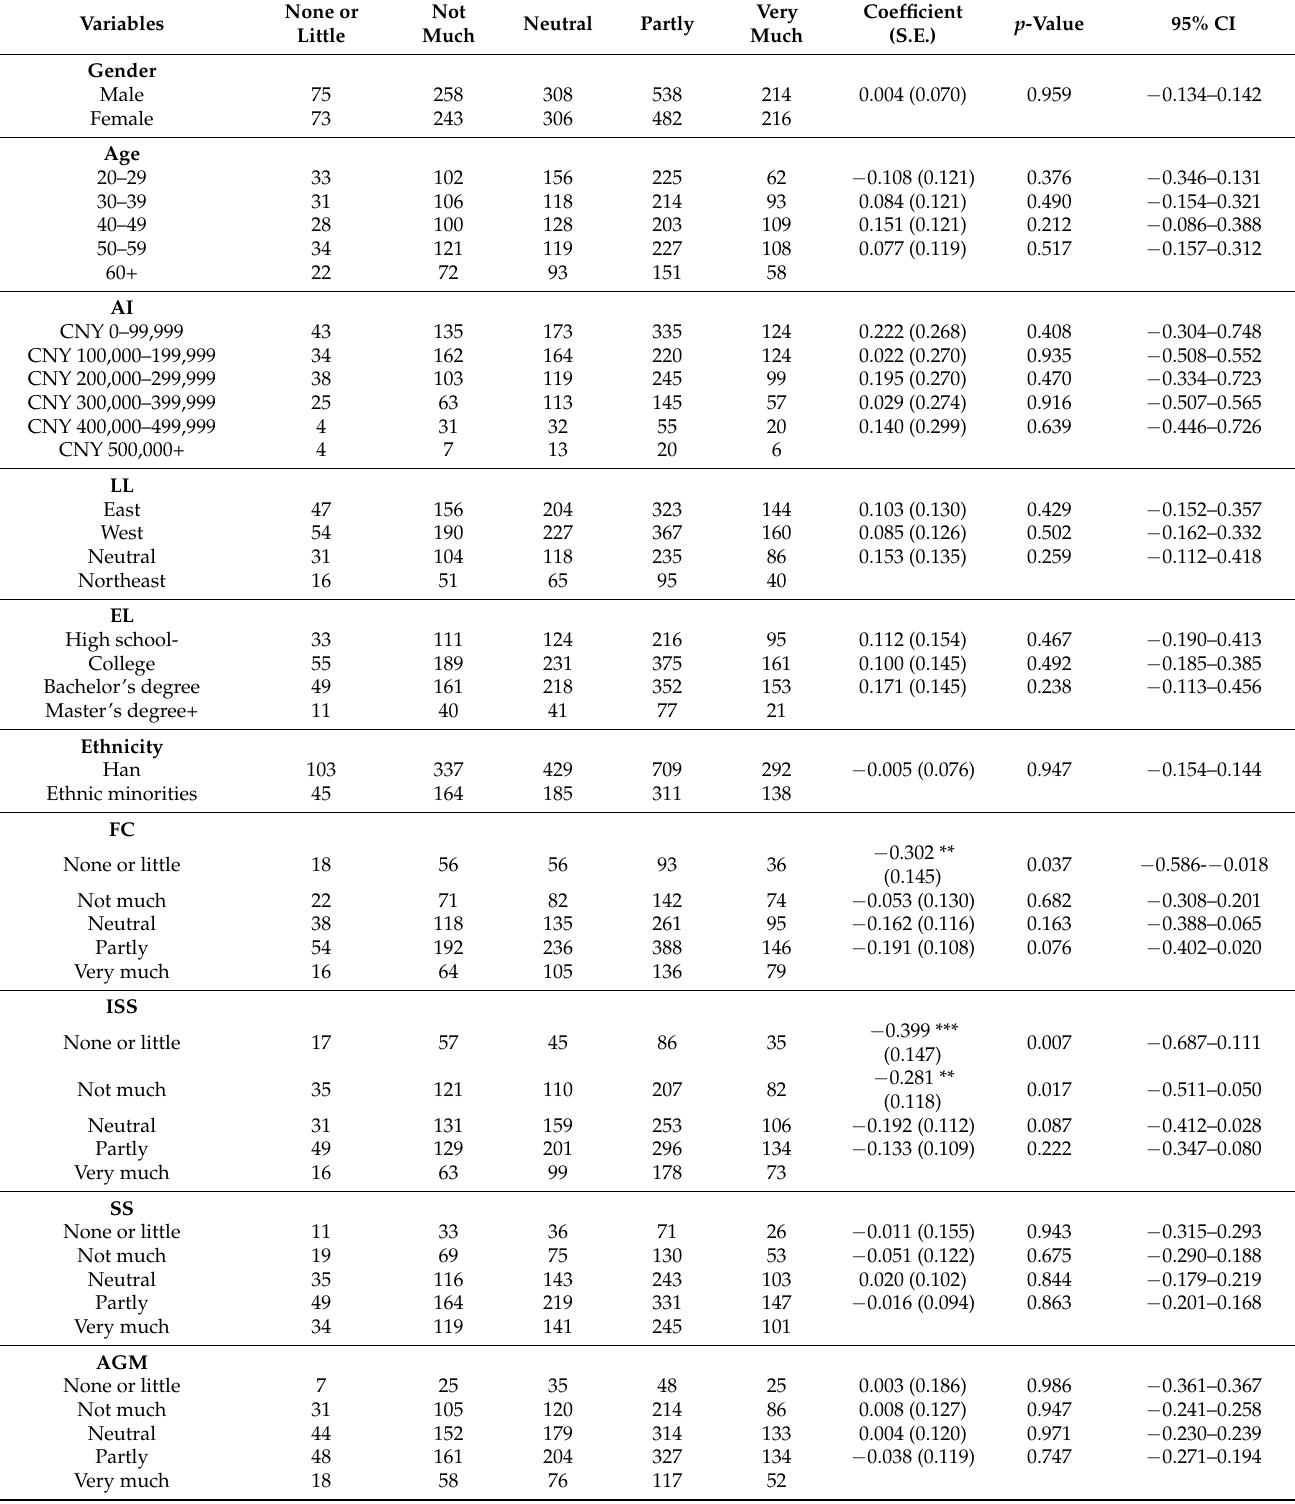
Table 3. Coefficients of the ordinal logit regression ( n =